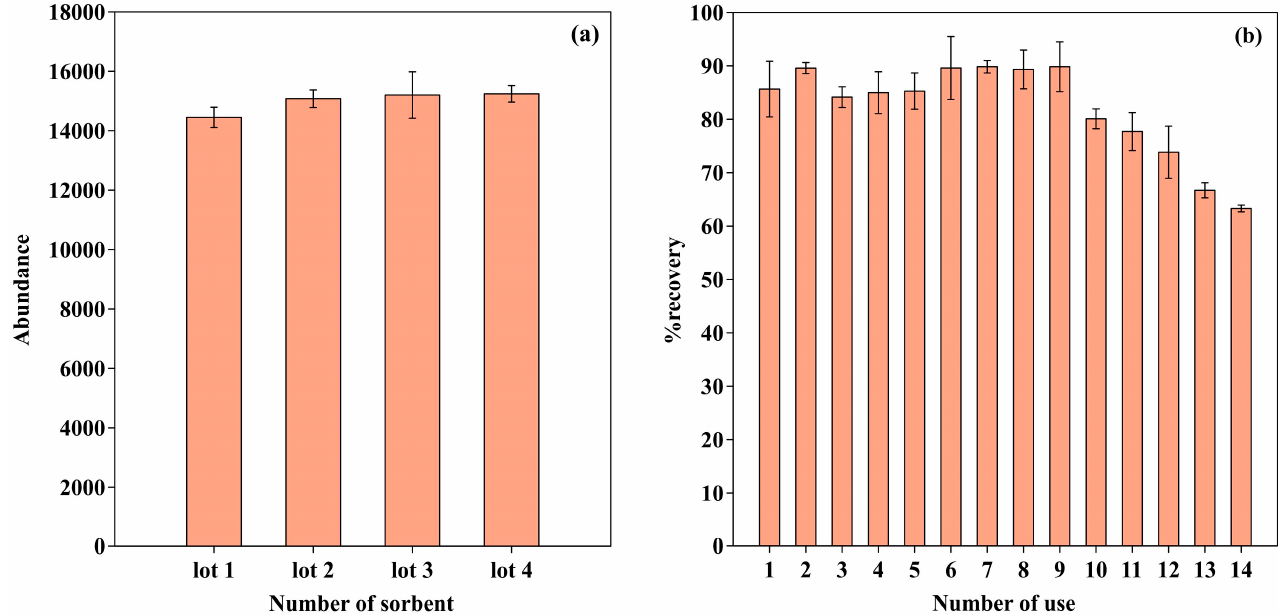
Figure 6. ( a ) Reproducibility and ( b ) reusability of GO-Cry. Table 3. Comparison of GO-Cry and other reported methods for the analysis of